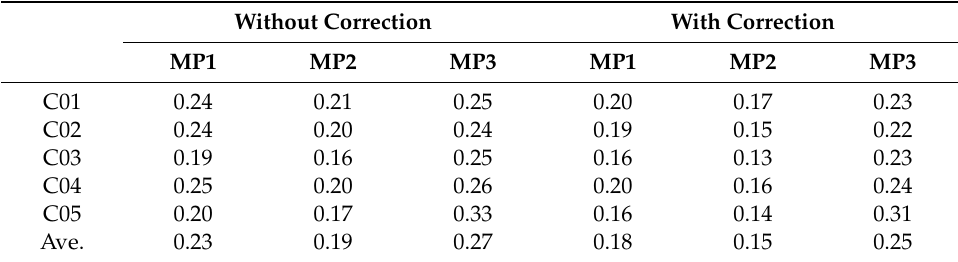
Figure 6. Root mean square error (RMSE) of the one-week multipath series of C04 satellite at CUT0 without (blue) and with (red) multipath correction. Table 1. Statistical results of each geostationary orbit (GEO) satellite for all stations without and with correction of multipath error (unit: m).